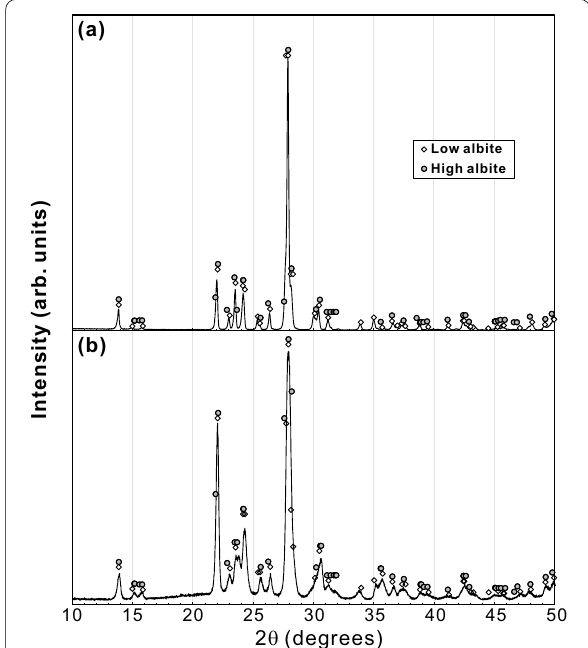
Fig. 1 Results of X‑ray diffraction analyses of a raw powder before hot pressing, and b a hot‑pressed sample (Exp.